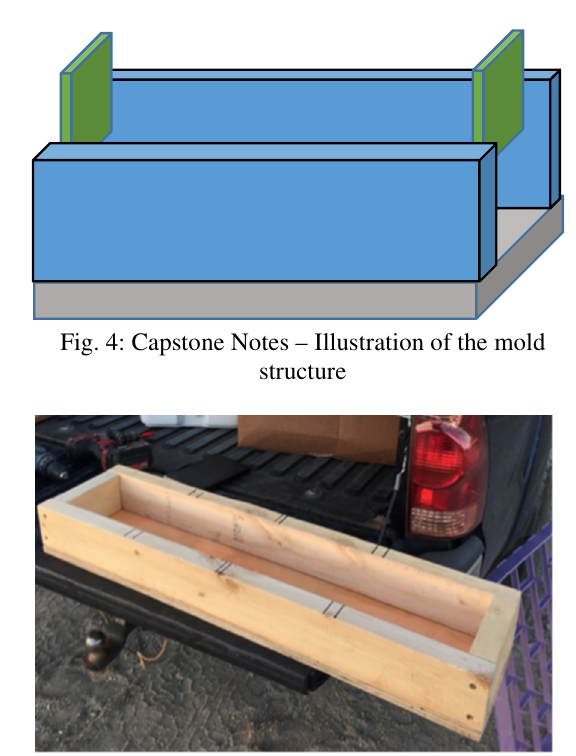
Fig. 5: The main structure of the mold before dividers were